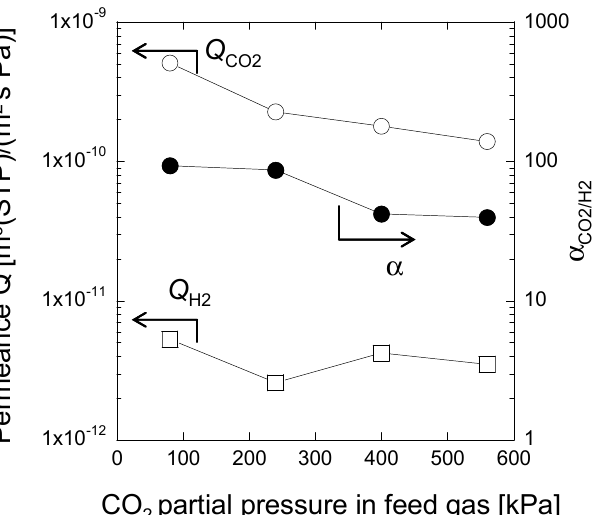
partial pressure in the feed gas on the CO Figure 8. Effect of CO 2 the PAMAM/cross-linked PVA composite membrane at 90% RH and 40